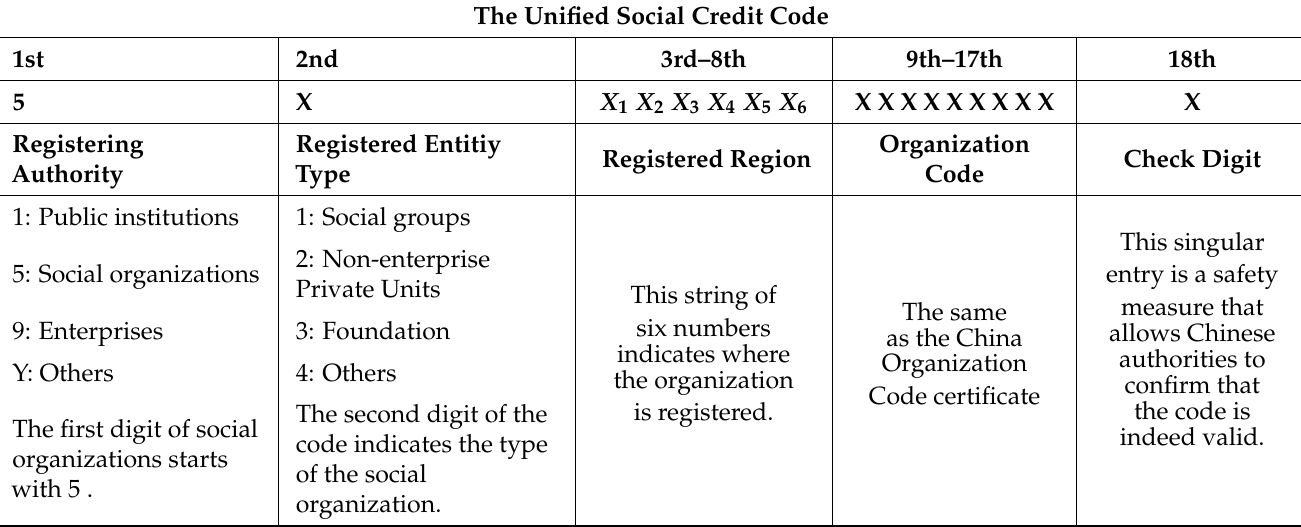
Table 2. The composition rules of the Chinese social unified credit code.